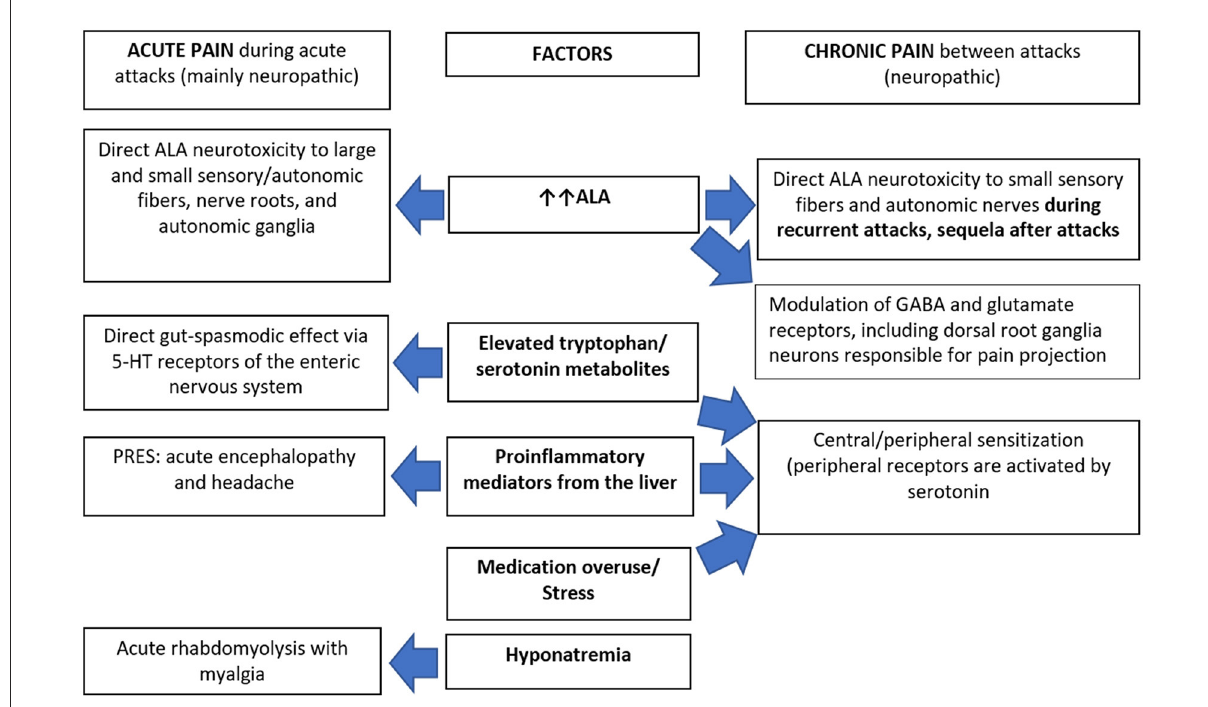
FIGURE2 Pathophysiology of pain in acute hepatic porphyrias. 5-HT, 5-hydroxy tryptamine (serotonin); ALA, δ -aminolaevulinic acid; GABA, gamma aminobutyric acid; PRES, posterior reversible encephalopathy